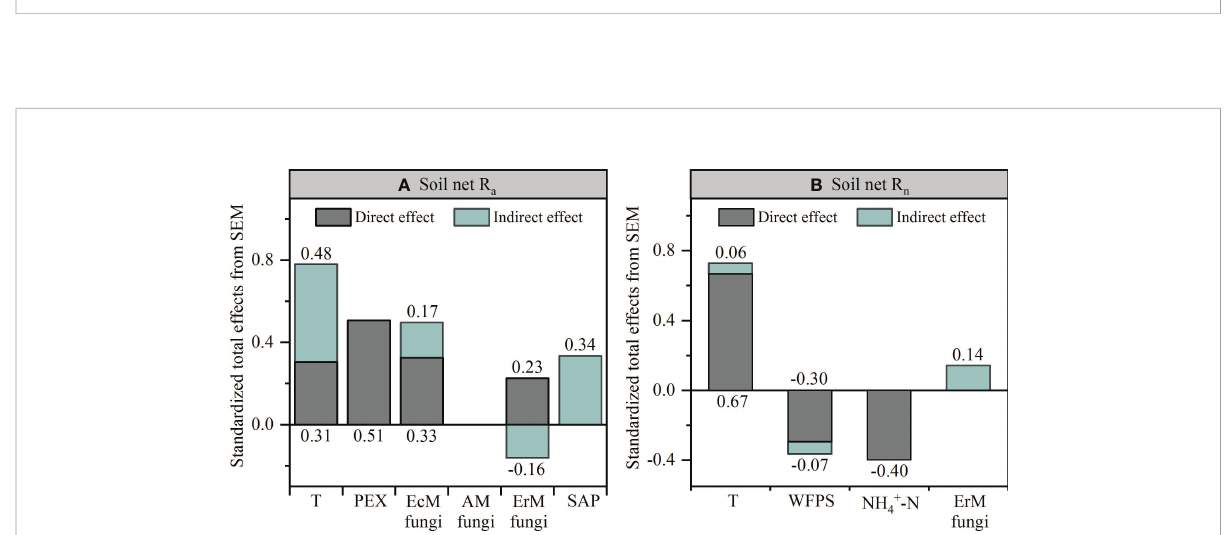
FIGURE 7 Standardized total effects of each variable on the soil net ammoni fi cation rate (Net R a ) (A) and soil net nitri fi cation rate (Net R n ) (B) from the structural equation modeling (SEM) analysis. T, temperature; PEX, peroxidase; WFPS, water- fi lled pore space; EcM fungi, ectomycorrhizal fungi; AM fungi, arbuscular mycorrhizal fungi; ErM fungi, ericoid mycorrhizal fungi; SAP, unde fi ned saprotroph.